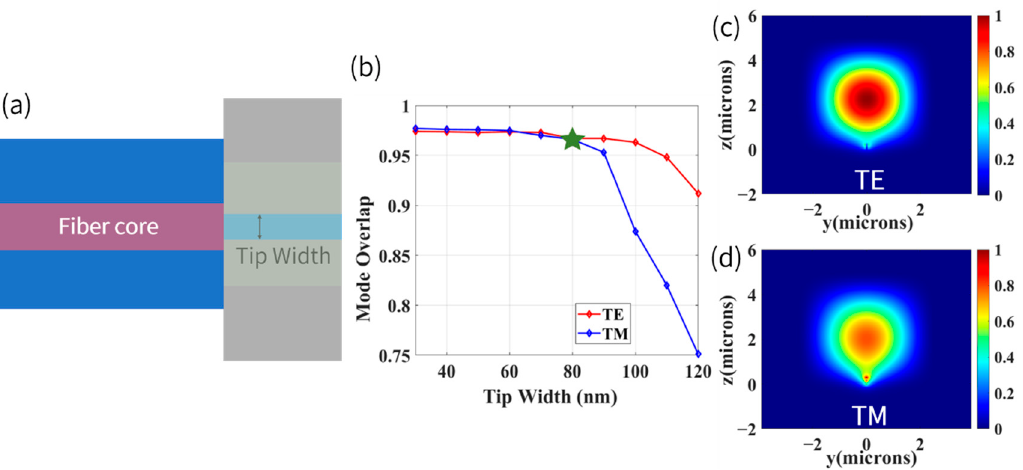
Figure 7. ( a ) Schematic of a setup for calculating mode overlap integral. ( b ) Mode overlap between tip and fiber with different tip widths (waveguide thickness = 260 nm). ( c ) Mode field distribution of TE mode at the tip end of inverse taper when the tip width was 80 nm. ( d ) TM mode.